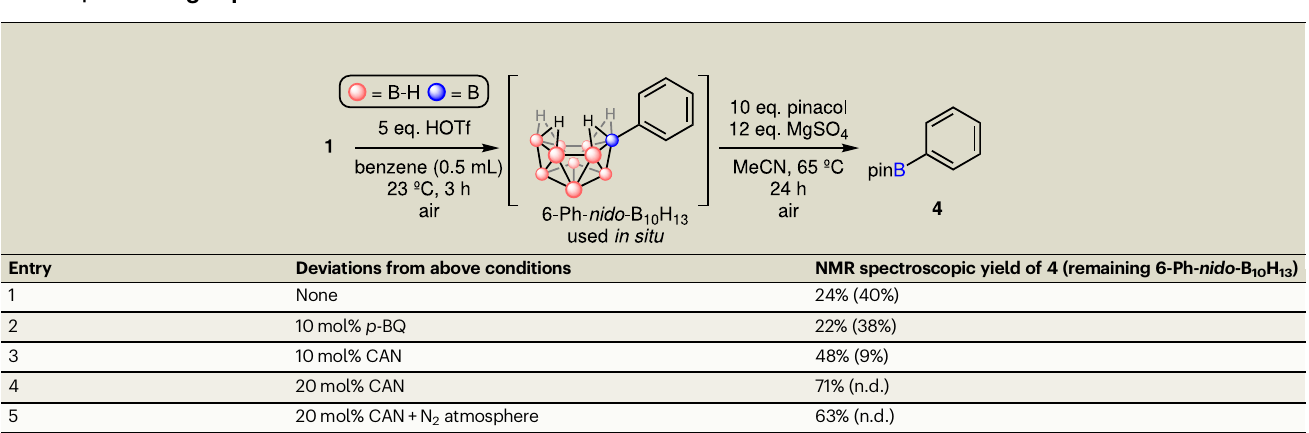
Table 1 | Screening experiments